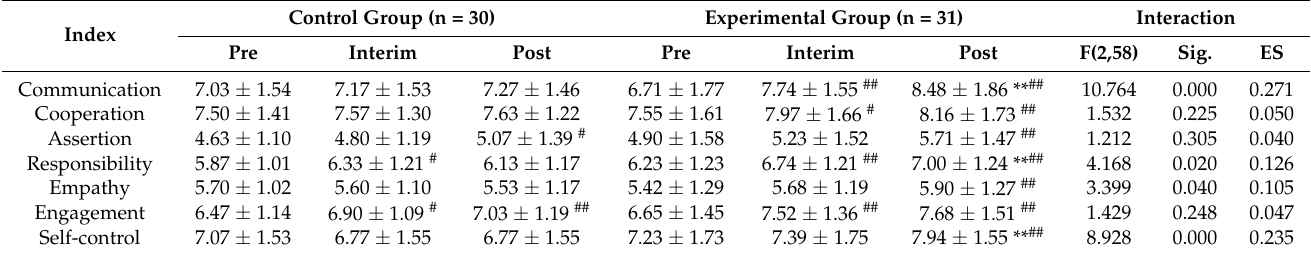
Table 5. Sub-domains of social skills of the SSIS across time for the THR group and control group. Control Group (n = 30) Experimental Group (n = 31) Interaction Index Pre Interim Post Pre Interim Post F(2,58) Sig. ES Communication